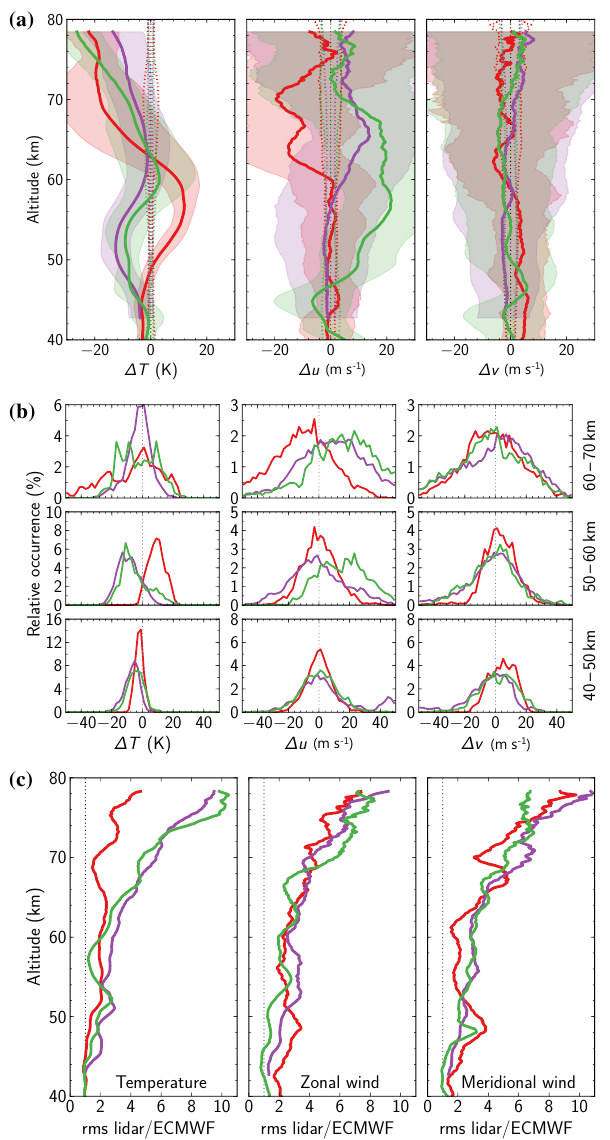
Figure 4. Differences between lidar data and ECMWF data for Jan- uary 2012 (red), January 2014 (purple), and January 2015 (green); the ECMWF cycles used are Cy37r3 for 2012 and Cy40r1 for 2014 (cid:54)(x ECMWF − x lidar ) ; shading rep- and 2015. (a) Mean difference 1 N resents the corresponding SDs; dotted lines depict the standard er- ror of the mean of the lidar data. (b) Distribution of differences x ECMWF − x lidar on an hourly basis for different altitude ranges. (c) Mean ratio of rms of lidar and ECMWF data. See Table 2 for an overview of the number of 1h profiles taken into account.